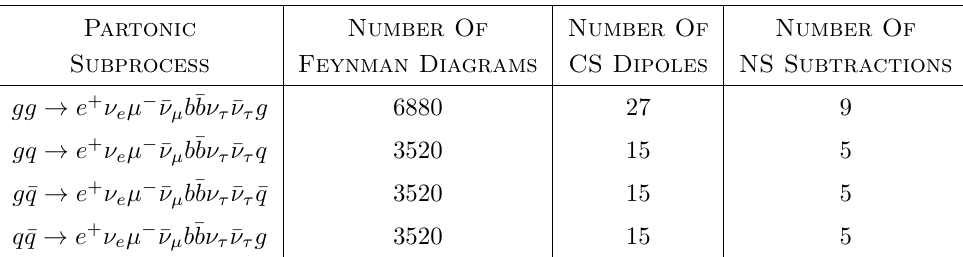
Table 2 . The list of partonic subprocesses contributing to the subtracted real emission at for the pp e + (cid:23) e (cid:22) (cid:0) (cid:22) (cid:23) (cid:22) b (cid:22) b(cid:23) (cid:28) (cid:22) (cid:23) (cid:28) + X process where q = u; d; c; s . Also shown are the number of ! Feynman diagrams, as well as the number of Catani-Seymour and Nagy-Soper subtraction terms that correspond to these partonic